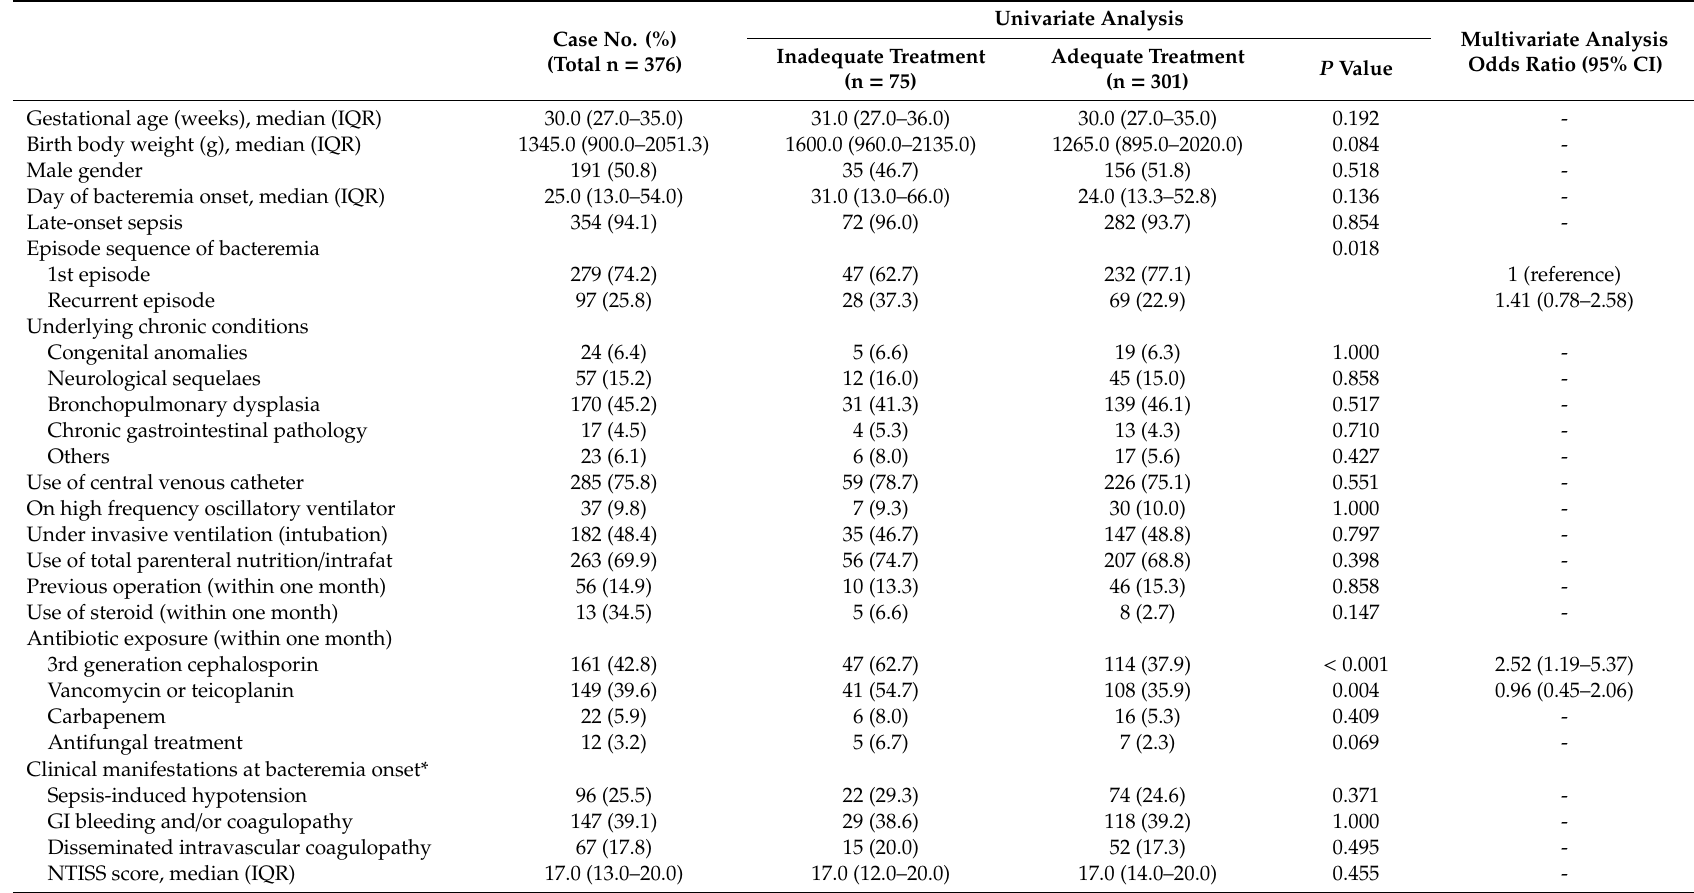
Table 2. Comparison of 376 episodes of Gram-negative bacteremias treated with inadequate versus adequate empirical antibiotic treatment. Case No.